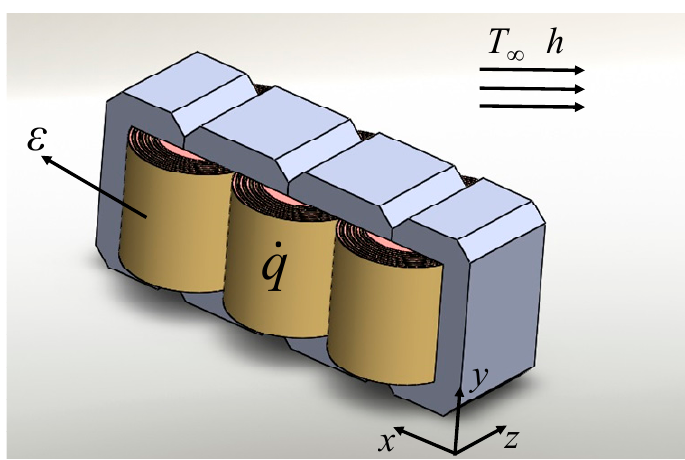
Figure 1. Representation of the thermal model of the core.